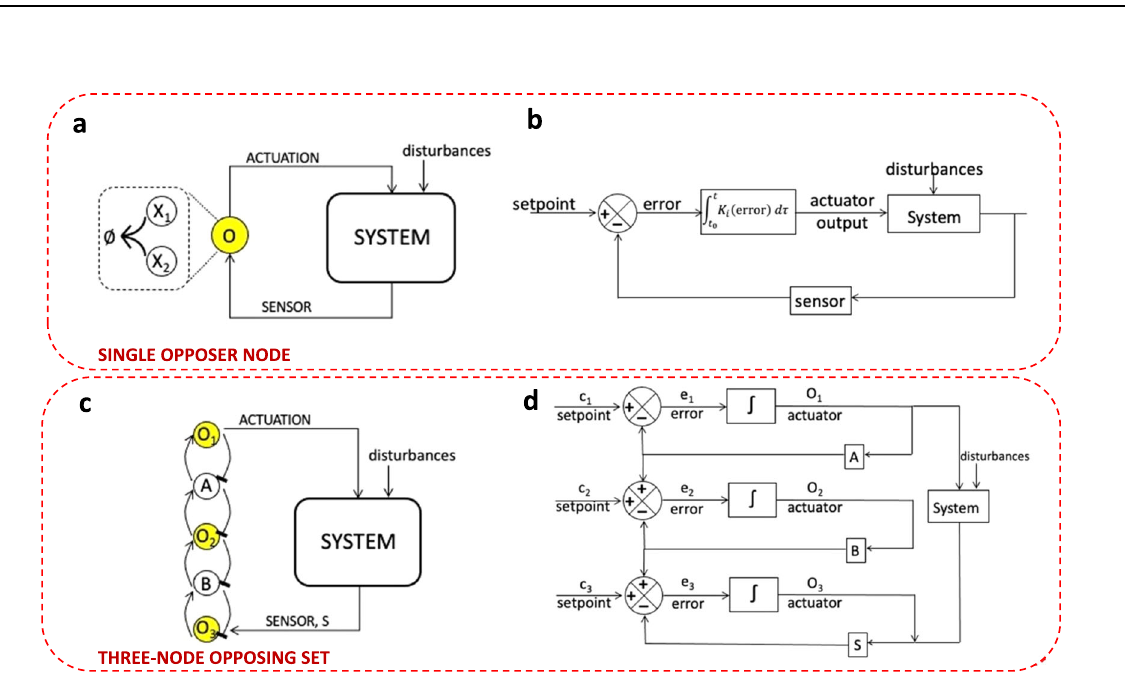
Fig. 8 | Stoichiometric independence of chemical reactions, and its con- sequencesforinvariantpassing.a AsimpleCRNwhichistopologicallyaBalancer module (see SI Section S3.1), involving interactions among three molecules: A (connector), B (diverter), and C (balancer). The connector polynomial (dA/dt) and thebalancerpolynomial(dB/dt)arestoichiometricallyindependent,sincetheCRN complexesthatcontributethemoleculeC(whichmustbeeliminated)are ‘ C ’ forthe connector polynomial, and ‘ B+C ’ for the balancer polynomial. A concatenating